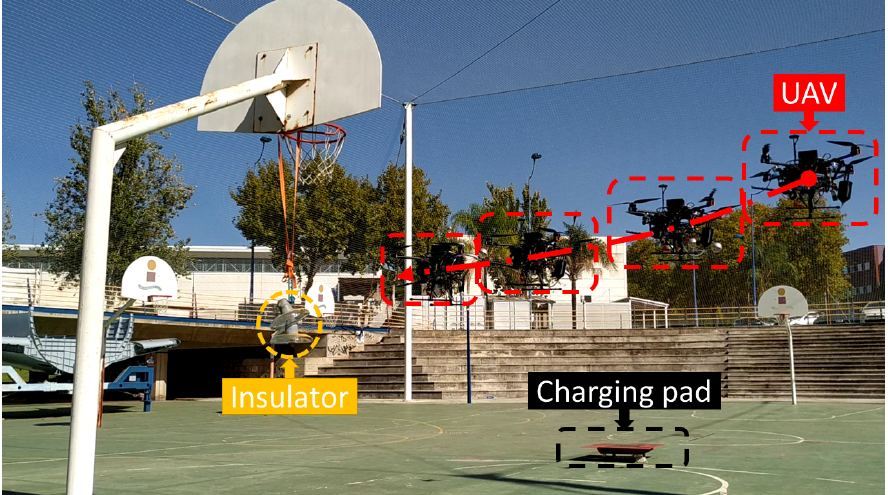
Figure 12. Path followed by the